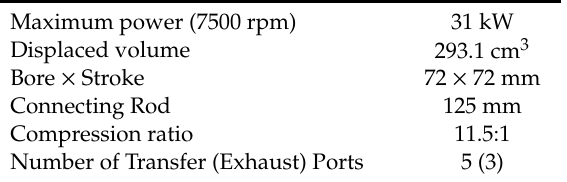
Table 1. Main characteristics of the Betamotor 300 cm 3 2S